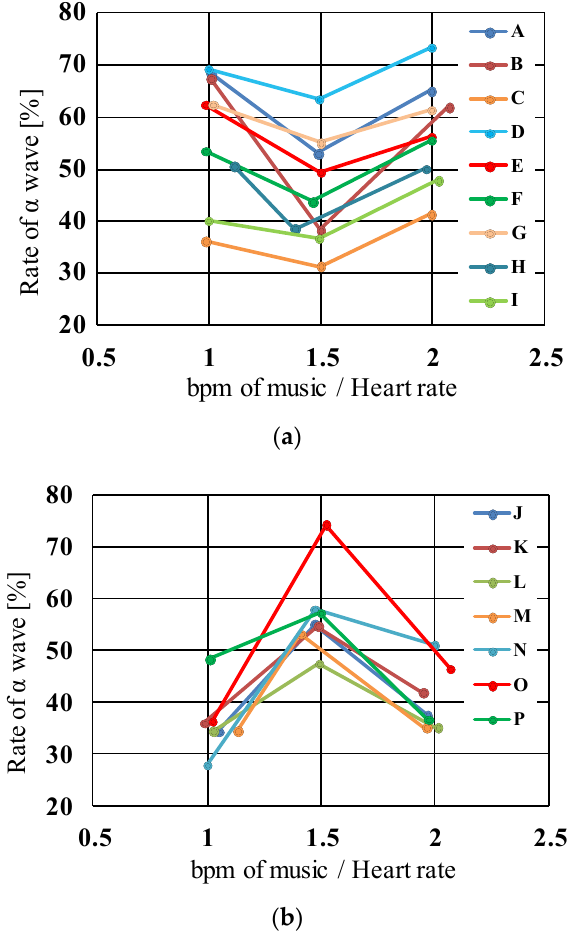
Figure 11. Experimental result for brain wave appearance rate of different noise condition. ( a ) α wave appearance rate that participants felt relax when listened to music of 1-time or 2-time tempo; ( b ) α wave appearance rate that participants felt relax when listened to music of 1.5-time tempo.